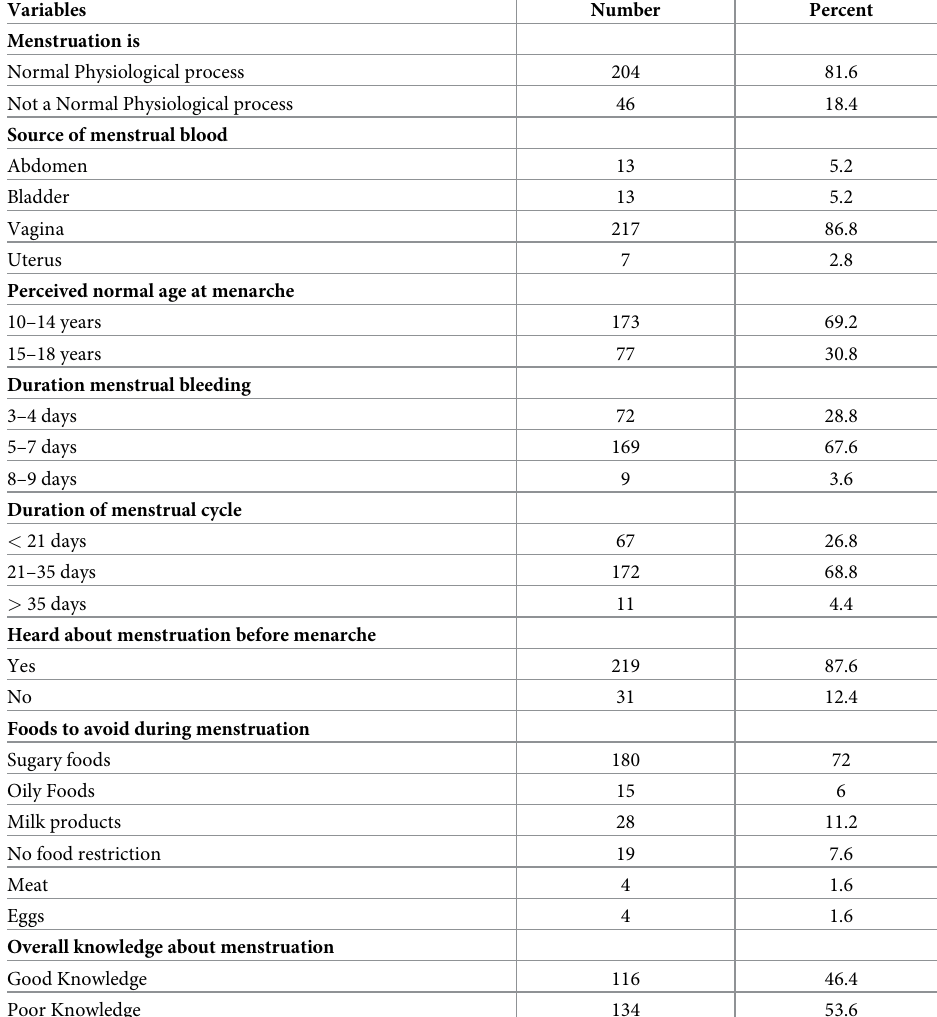
Table 2. Adolescent schoolgirls knowledge about